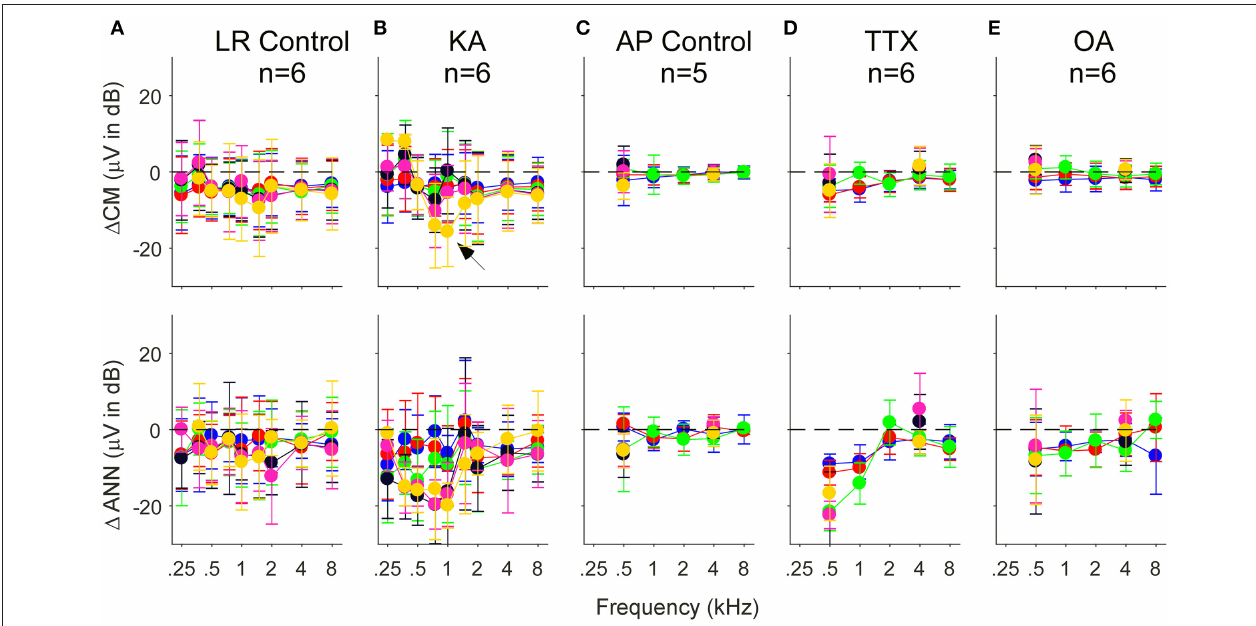
FIGURE 9 | Difference in the CM (top row) and ANN (bottom row) before and after application of vehicle only or vehicle between the Pre and Post data for each animal. (A,C) Control cases where vehicle only was applied to the round window. For the lactated Ringer’s (LR) there was a small reduction in both the CM and ANN that could be related to the passage of time (A) . For the artificial perilymph (AP), the smaller frequency, and intensity range decreased the time between recordings, and the reduction in the CM and ANN was smaller (C) . (B,D,E) Responses after KA, TTX, and OA, respectively. After KA (B) , the reduction in the CM to 750 and 1,000Hz, also shown in the previous figure, was greatest to the lowest intensity (arrow). After TTX (D) , the reduction in the ANN was large at 500 and 1,000Hz, and similar to controls the higher frequencies. After OA (E) , the reduction to the lower frequencies was smaller than with KA or TTX. Errors bars are standard